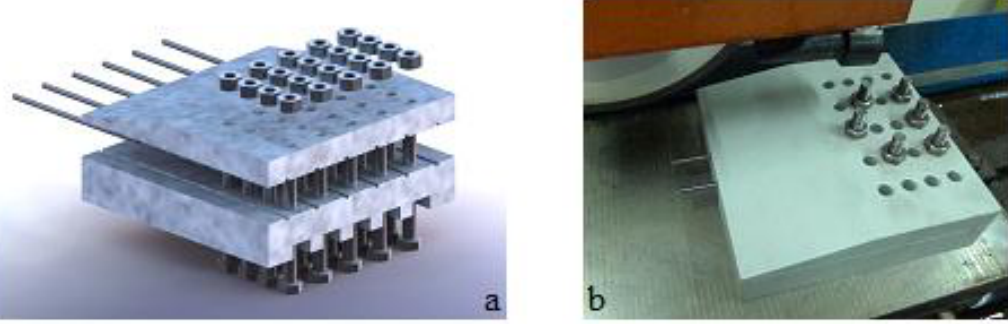
Figure 3. The customized fixture. ( a ) Exploded diagram of the fixture design; ( b )